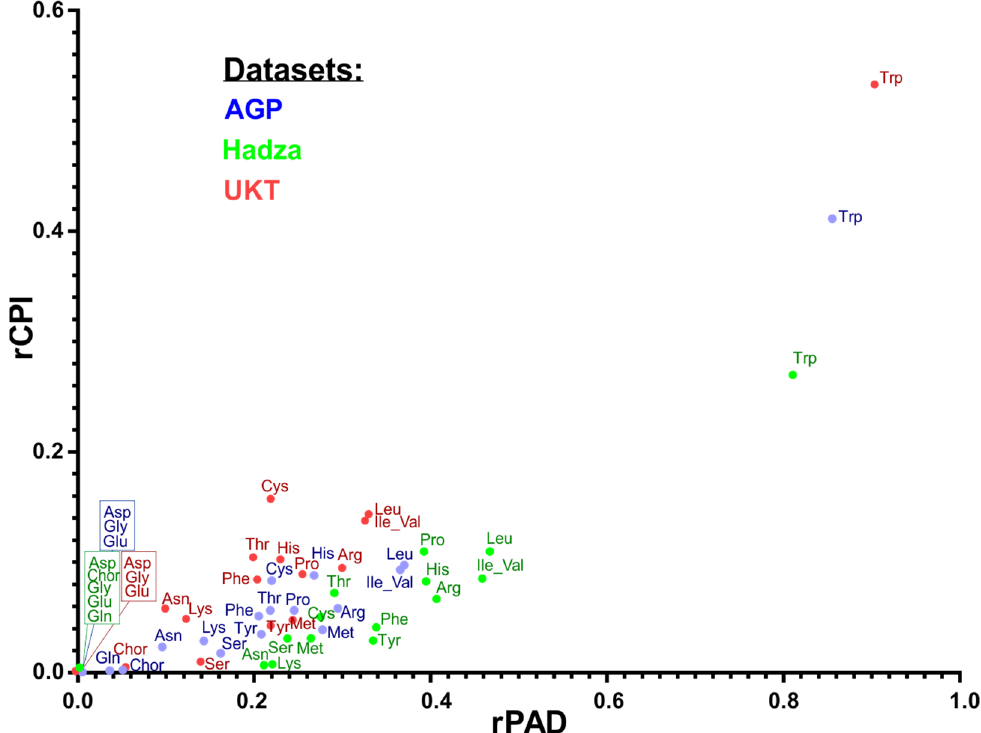
Figure 5. Mutual dependence of median rCPI and rPAD values for each amino acid synthesis phenotype in three HGM